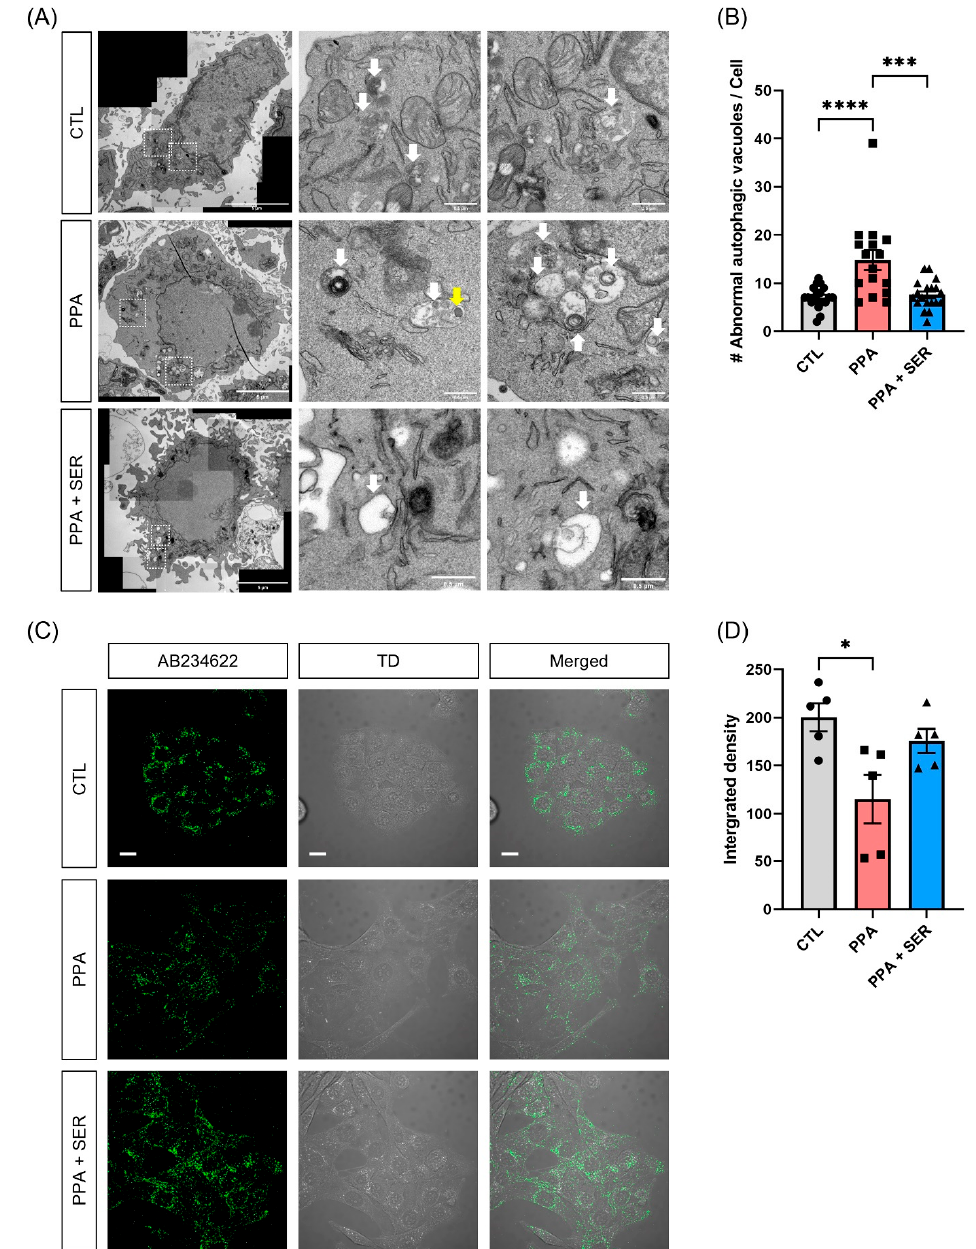
Figure 2. PPA induced lysosomal abnormality and decreased lysosomal activity in HT22 cells. Cells were treated with 5 mM PPA only or 5 mM PPA and 10 mM L-serine (SER) for 48 h. ( A ) Representative electron microscopic images of autolysosome in HT22 cells. PPA induced the lipid membrane- bounded inside the lysosomes in HT22 cells. The white arrow represents the autolysosome structure, and yellow arrow represents the lipid droplet inside the autolysosome. Scale bar, 5 µ m (left); 0.5 µ m (the magnified images). ( B ) Quantification of the abnormal autophagic vacuoles analyzed by TEM images ( n = 15). SEM, *** p < 0.001, **** p < 0.0001 by one-way ANOVA, Tukey’s multiple- comparison test. ( C ) Representative fluorescence images of the release of the self-quenched substrate in HT22 cells. Confocal images showed lysosomal activity with green fluorescence. Scale bar, 20 µ m. ( D ) Quantification of the integrated density of lysosomal activity in HT22 cells ( n = 5). PPA significantly reduced lysosomal activity compared to control. L-serine (SER) restored lysosomal activity compared to PPA. * p < 0.05 by one-way ANOVA, Tukey’s multiple-comparison test. TD: transmitted light detector image. AB234622: Lysosomal intracellular activity assay